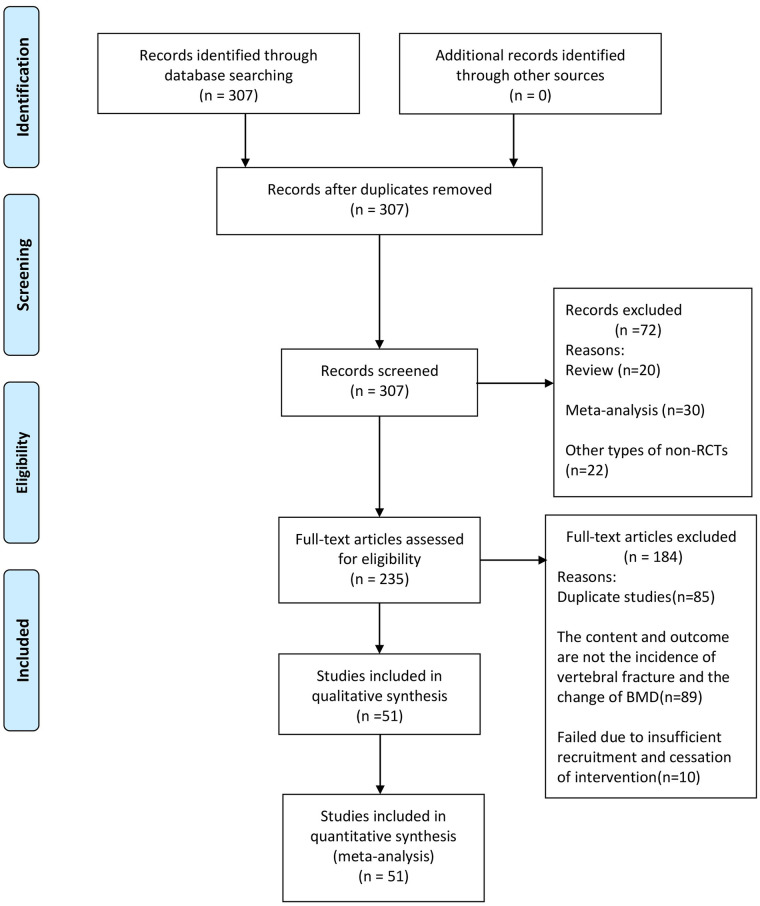
Flow diagram of literature search and study inclusion.